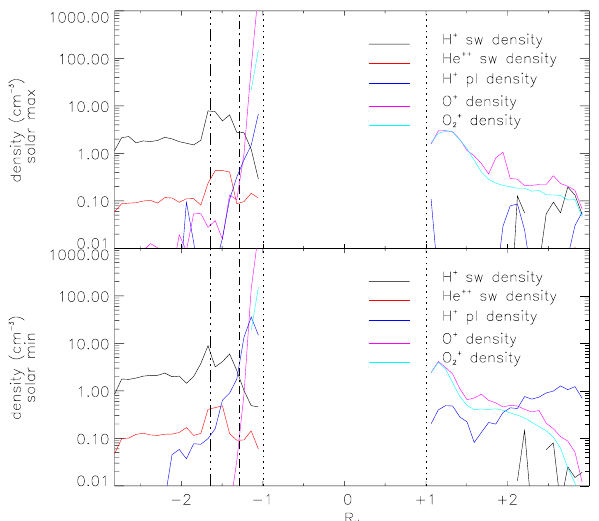
Fig. 4. Ions density profile following the Sun–Mars direction. Plan- etary (H + , O + and O + ) and solar wind ions (H + sw and He ++ ) den- pl 2 sities are plotted in both cases: solar maximum (top panel) and so- lar minimum (bottom panel). The first vertical dashed-dotted line represents the average subsolar point of the bow shock, and the sec- ond vertical dashed-dotted line represents the subsolar point of the